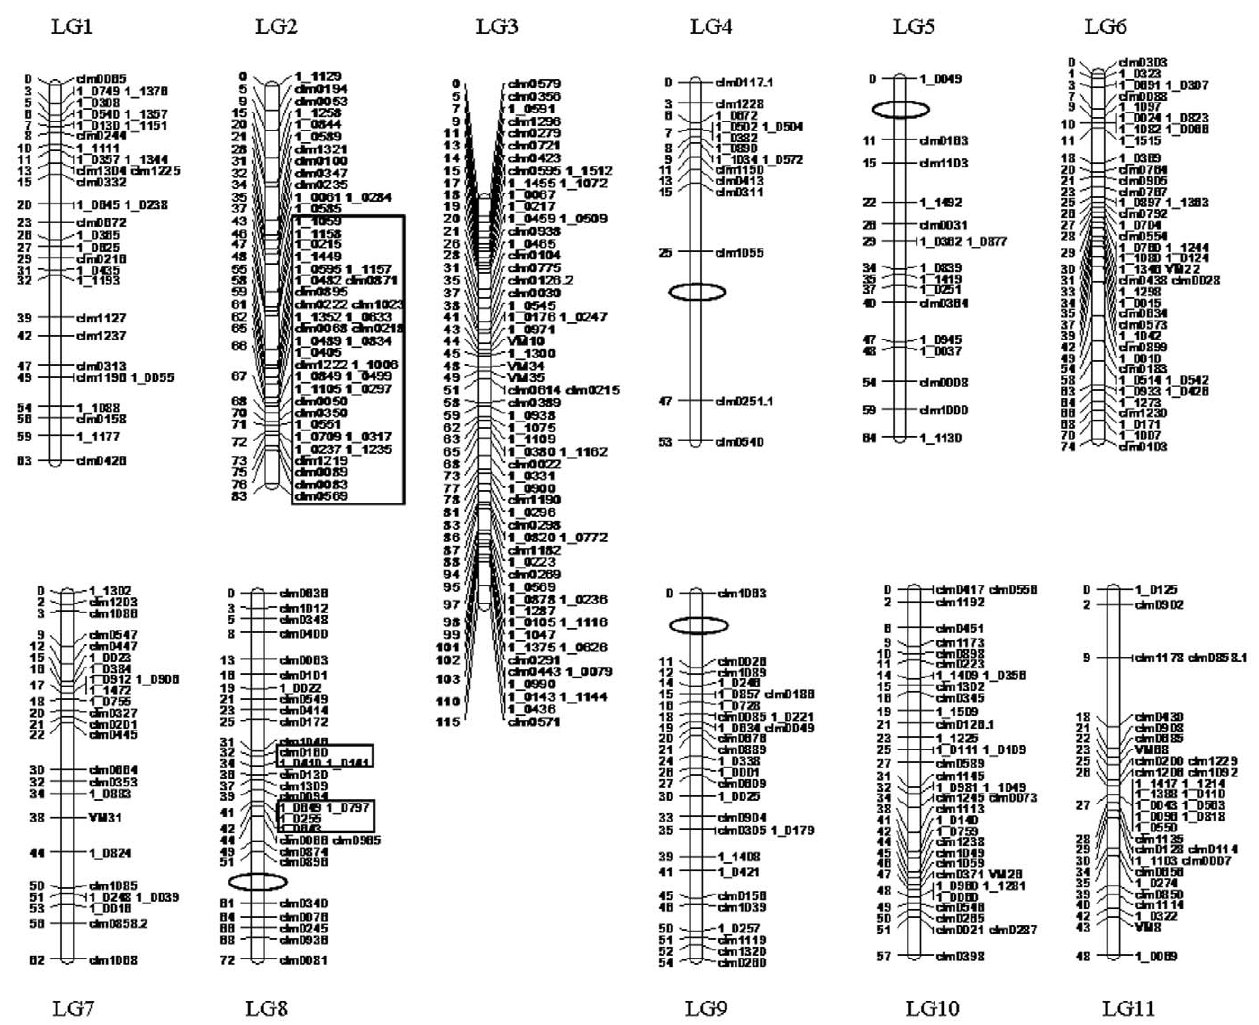
Figure 1. The ‘ZZ’ genetic linkage map of asparagus bean. Numbers to the left of each LG are marker positions (cM). Open ovals indicate gaps greater than 10 cM. Regions defining distorted segregation are boxed.